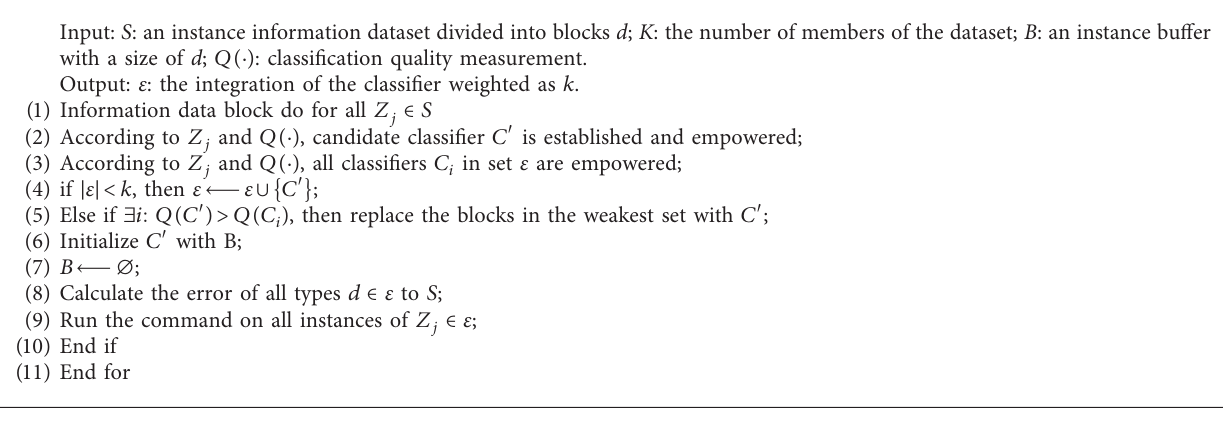
A LGORITHM 1: Dataset block integration algorithm.